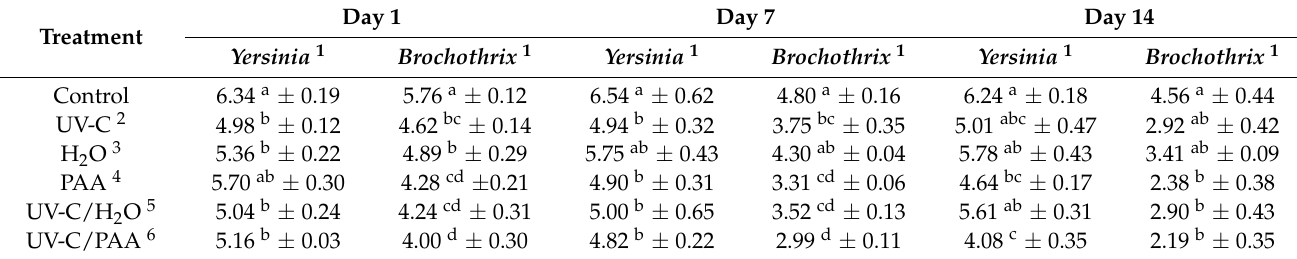
Table 2. LSM ± SE of Yersinia enterocolitica and Brochothrix thermosphacta counts on pork previously inoculated with these bacteria after UV-C, peracetic acid (PAA), and H 2 O treatments alone and in combination after 1, 7, and 14 days of storage ( n = 3).